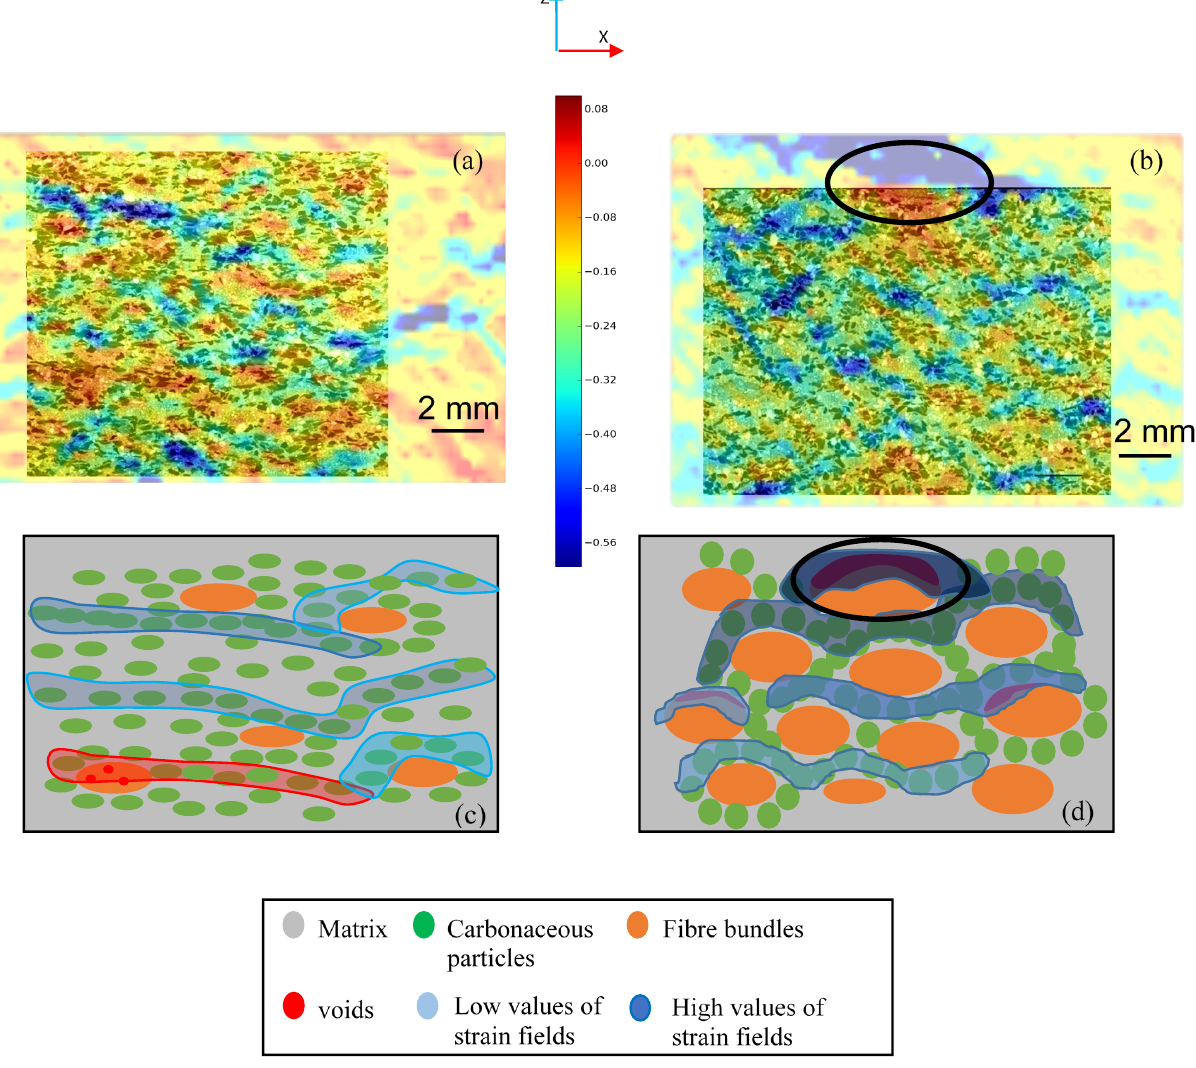
Figure 10. Strain fields Ezz (%) in the compression direction at 10 MPa superimposed on the microstructure for ( a ) M1 and ( b ) M2, and the schematic relationship with constituent distribution for ( c ) M1 and ( d ) M2.